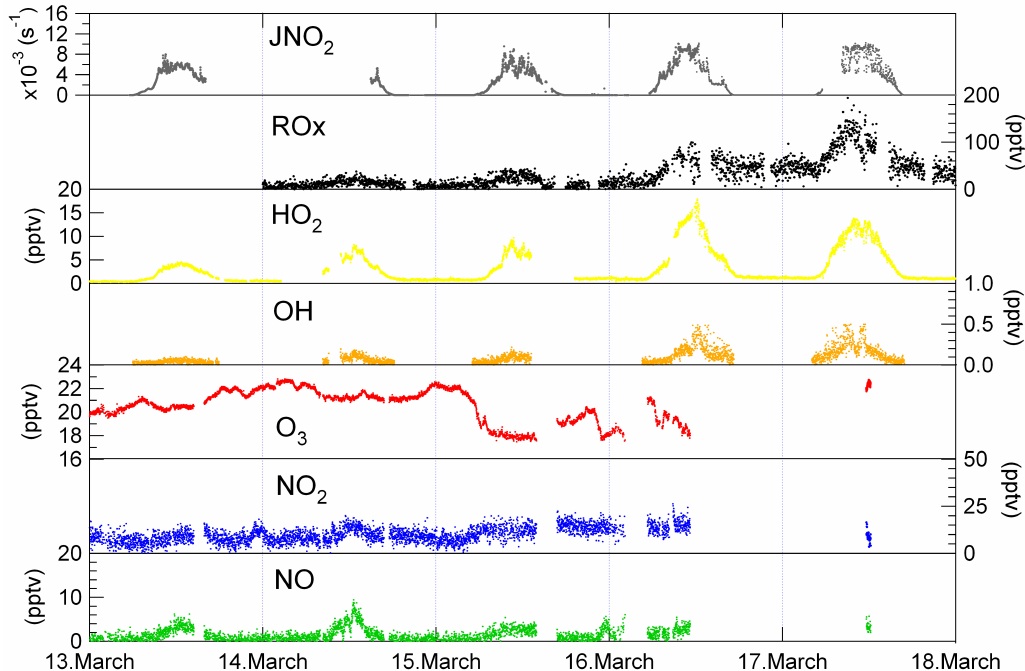
Fig. 8. Measured diurnal profiles of NO, NO 2 , O 3 , J NO emissions).